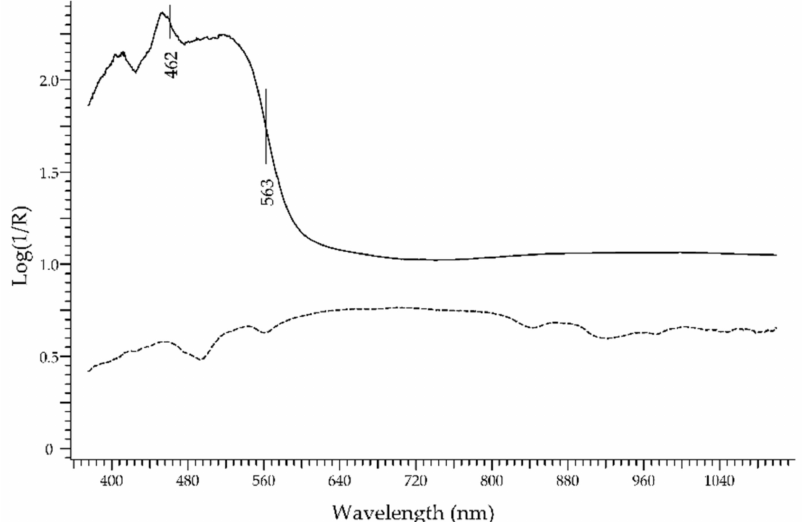
Figure 16. FORS spectrum in Log(1/R) coordinates of a Mexican fire opal (solid line) and an Ethiopian dyed opal (dashed line).